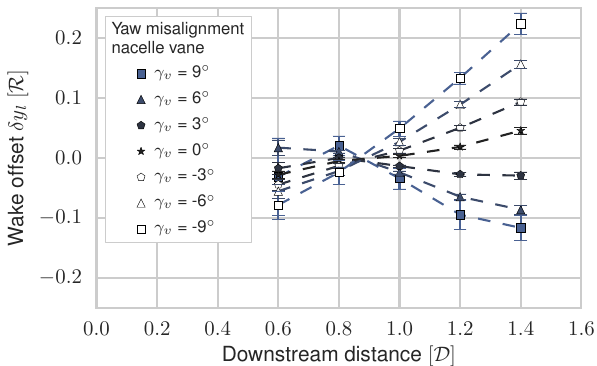
Figure 8. Mean near-wake paths measured by lidar wake tracking classified in 3 ◦ bins with respect to yaw misalignment measured with the nacelle vane. Bars show standard error on the